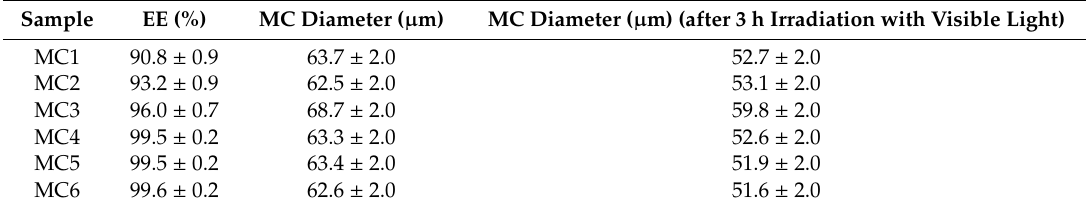
Table 2. Encapsulation e ffi ciency (EE) and microcapsules size before and after 3 h of irradiation with visible light determined by Laser Di ff raction Particle Size